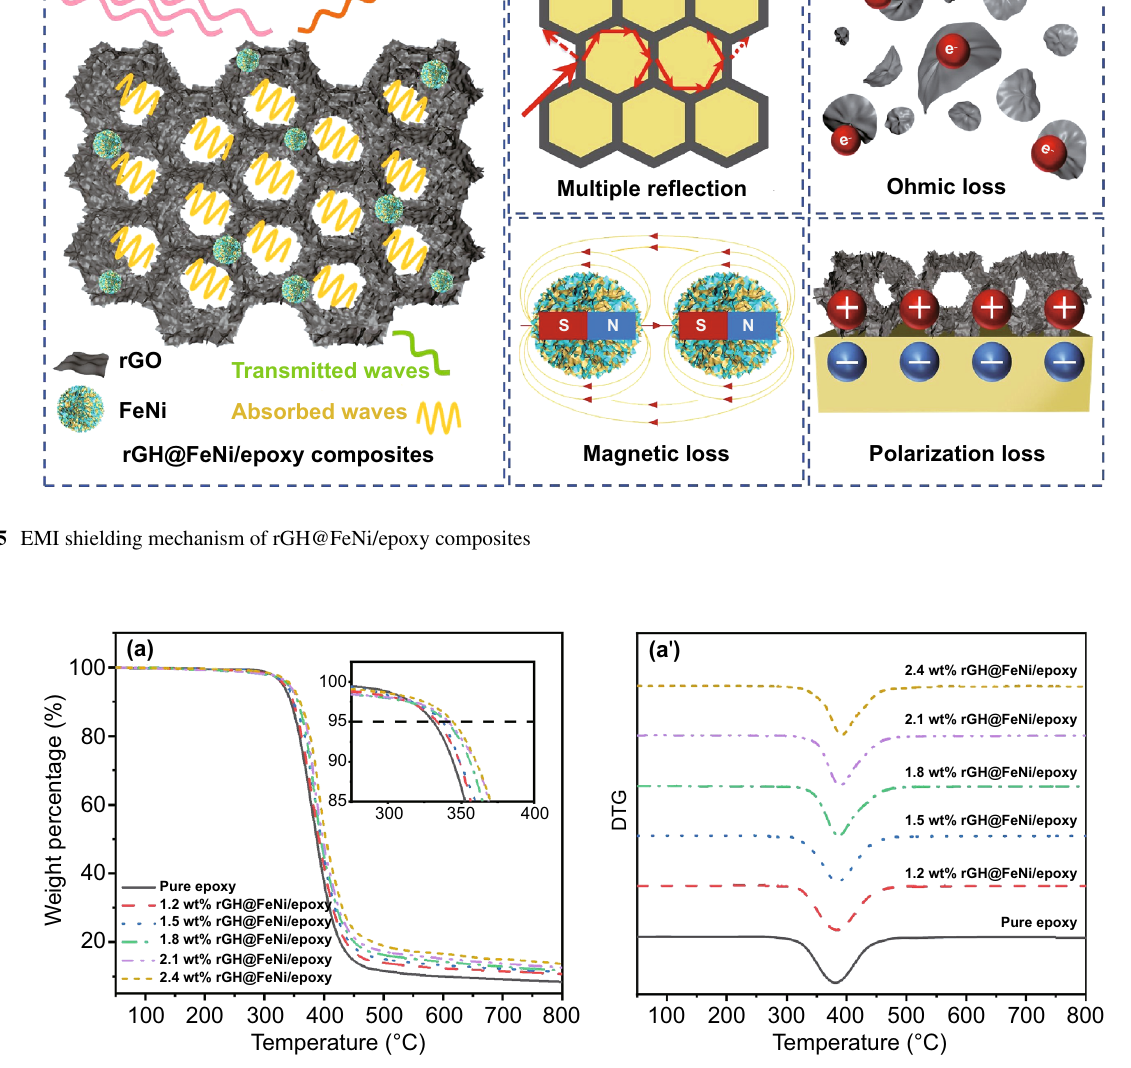
Fig. 6 TGA ( a ) and DTG ( a ′ ) curves of the rGH@FeNi/epoxy